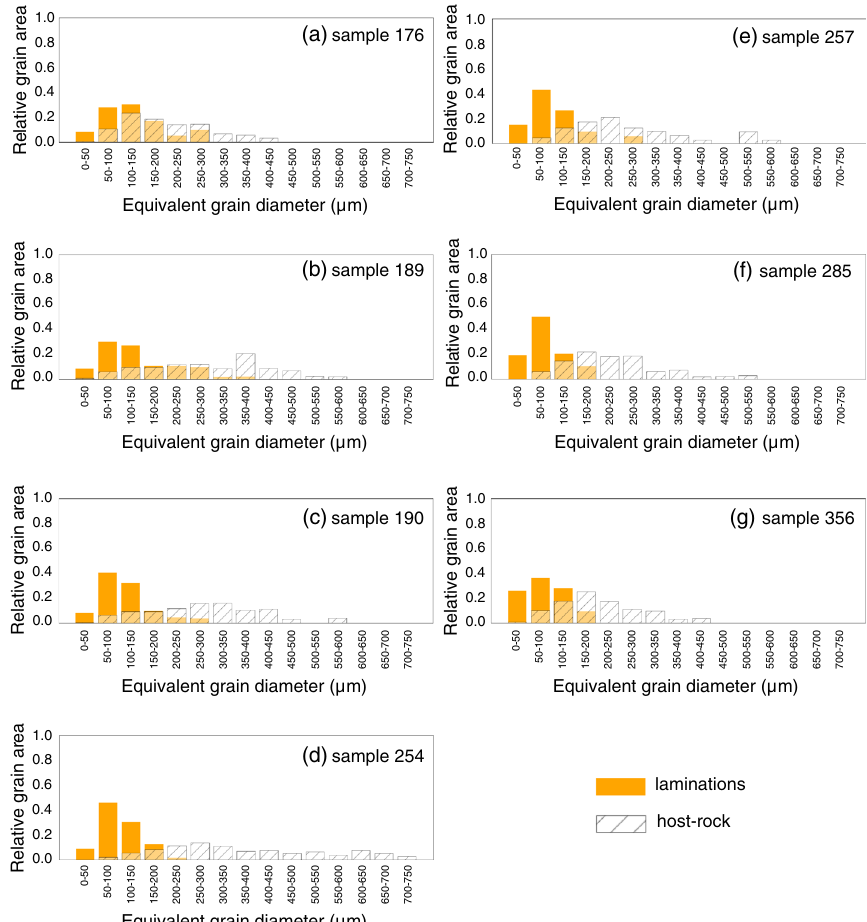
Fig. 8 Histograms showing relative grain area as a function of equivalent grain diameter for each of the seven cores investigated in this study (shown in Fig. 3). a Sample 176. b Sample 189. c Sample 190. d Sample 254. e Sample 257. f Sample 285. g Sample 356. The orange bars show the grain area distribution in the laminations and the shaded bars show the grain area distribution in the